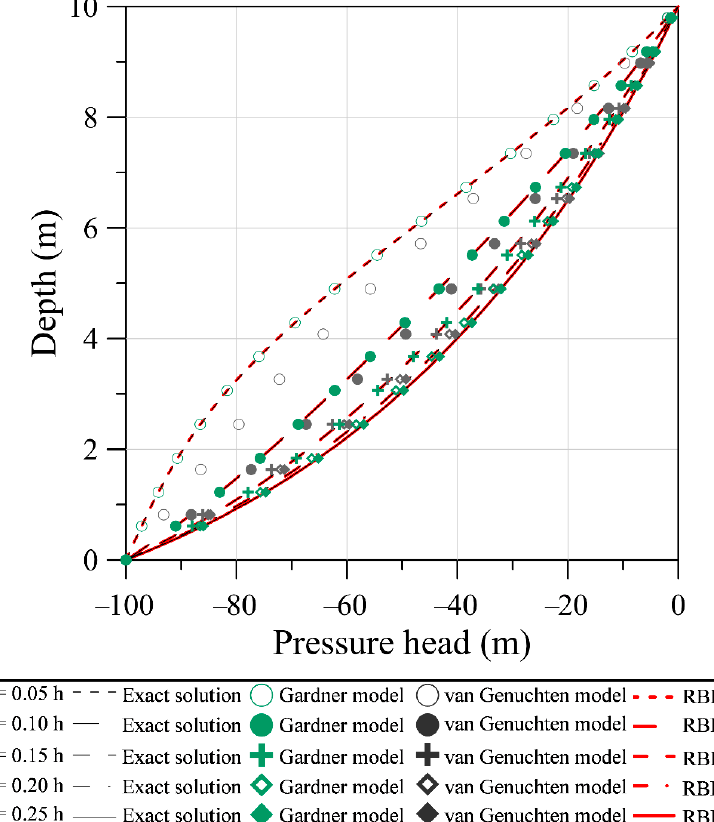
Figure 10. Comparison with the exact solutions.